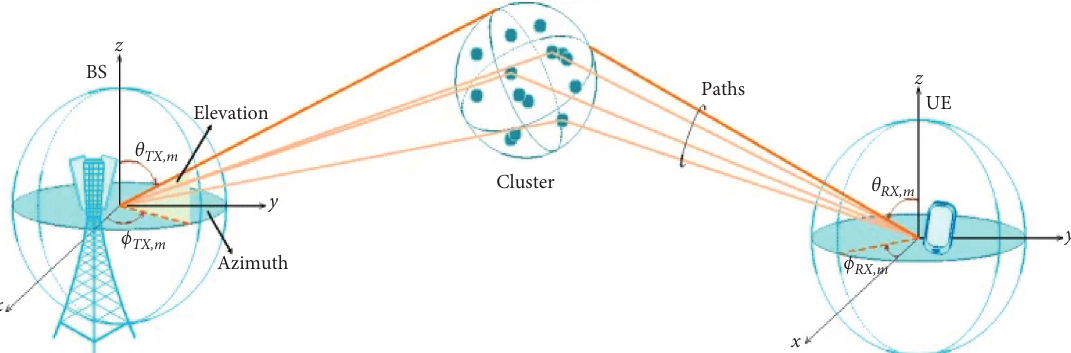
Figure 2: Simplified representation of the 3D-3GPP channel model